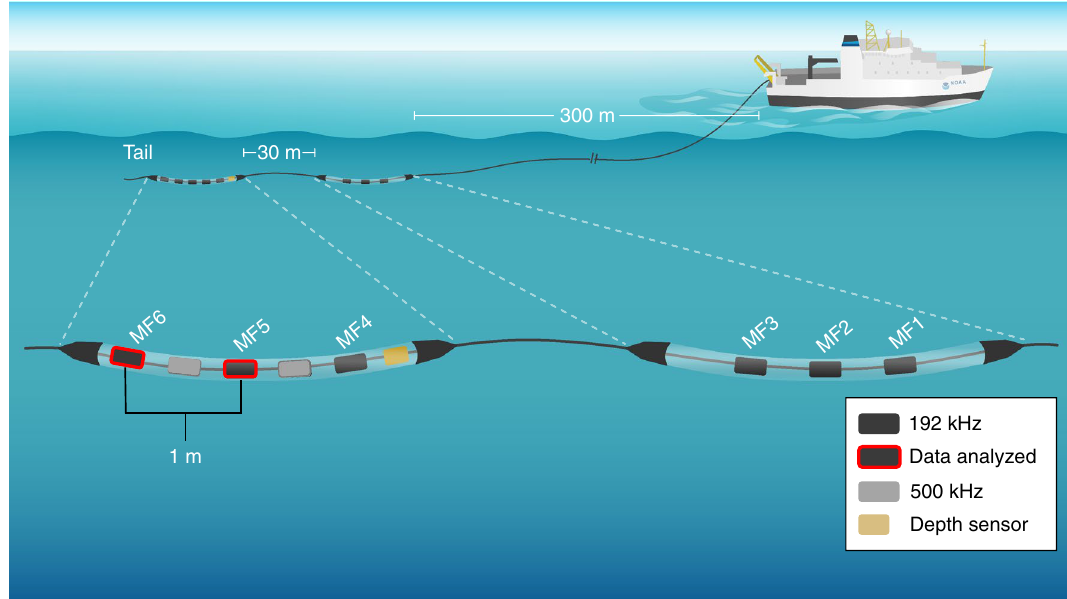
Figure 1. The linear towed array included eight hydrophone elements and a depth sensor within two oil-filled modular sections separated by 30 m of cable. Six hydrophones sampled at 192 kHz (MF1–MF6) and two sampled at 500 kHz. The hydrophones were connected to two National Instruments sound cards (NI-USB-6356). A high pass filter of 1 kHz was applied by the recording system to reduce the amount of